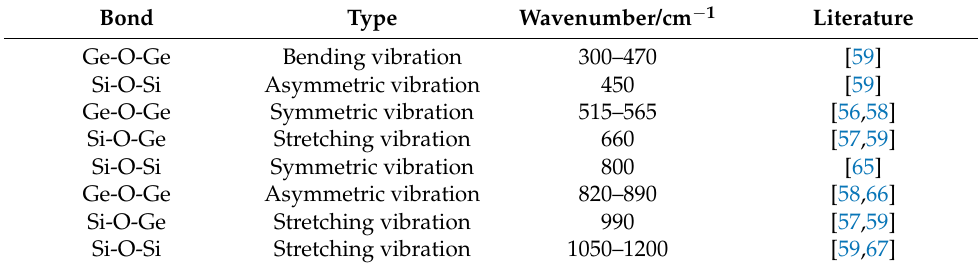
Figure 4. IR spectra evolution of GeO 2 glass ( a ) and SiO 2 glass ( b ) with increasing comminution time. The colored lines correspond to the absorption bands displayed in Table 6. Table 6. Main IR absorption bands for SiO 2 - and GeO 2 -based